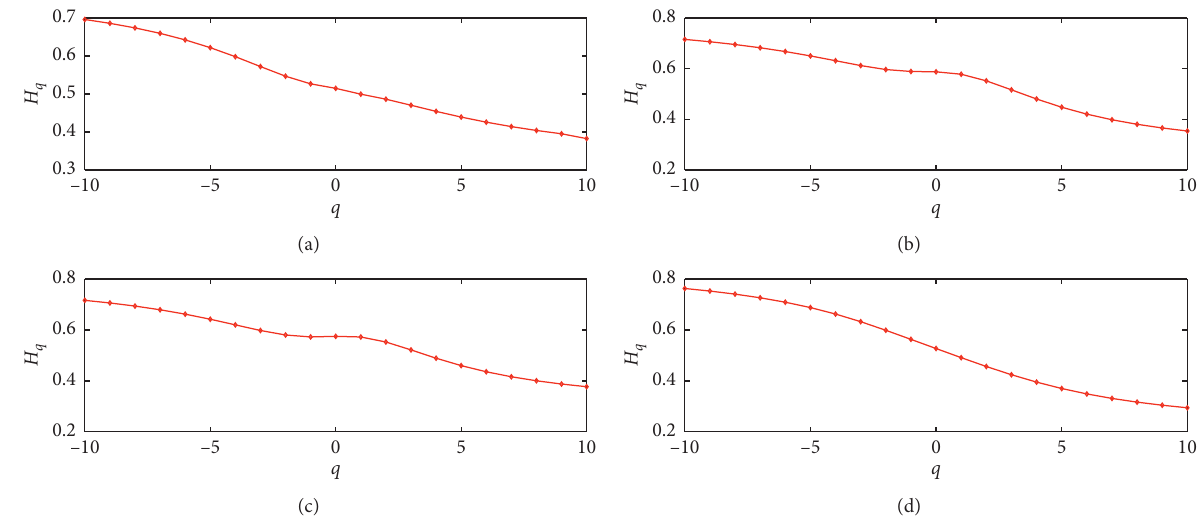
Figure 8: MF-DCCA scaling exponent for the market participation willingness and Chinese stock market returns. (a) SME-YSI. (b) SSE50- YSI. (c) CSI300-YSI. (d) GEM-YSI.